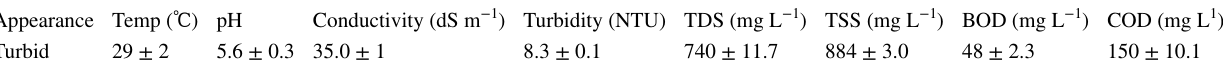
Table 1 Physicochemical properties of abattoir wastewater used